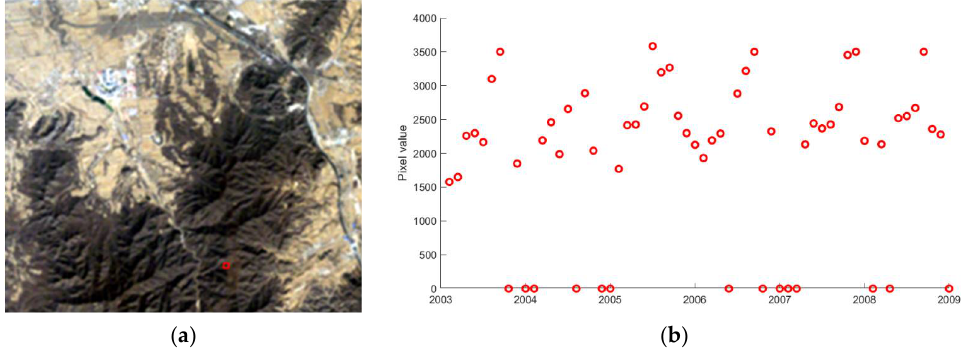
Figure 3. ( a ) Original image (20030327). ( b ) Scatter plot of the time series of the near-infrared band from 2003 to 2008 for a pixel of ( a ) in the red box.